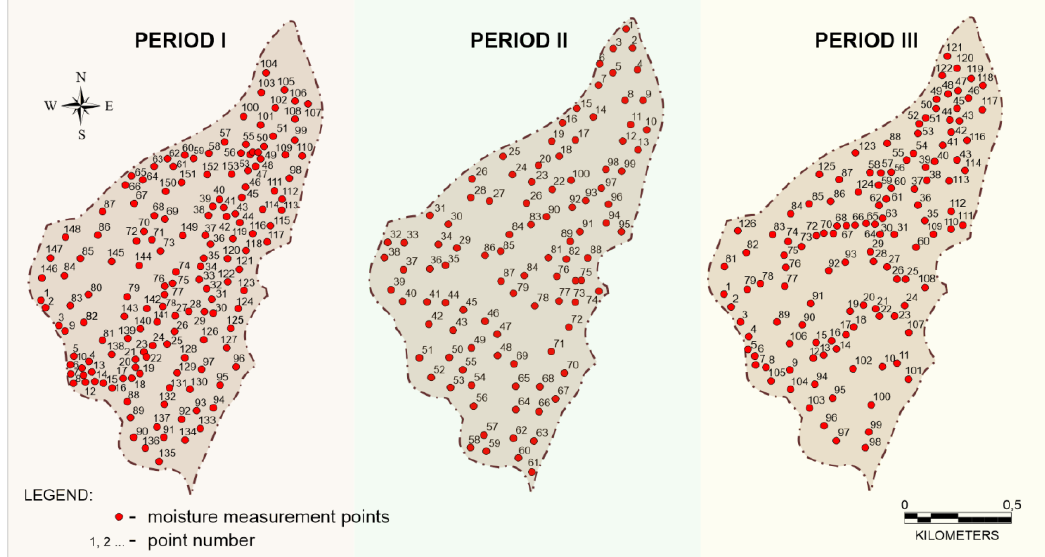
Figure 3. Location of moisture measurement points.